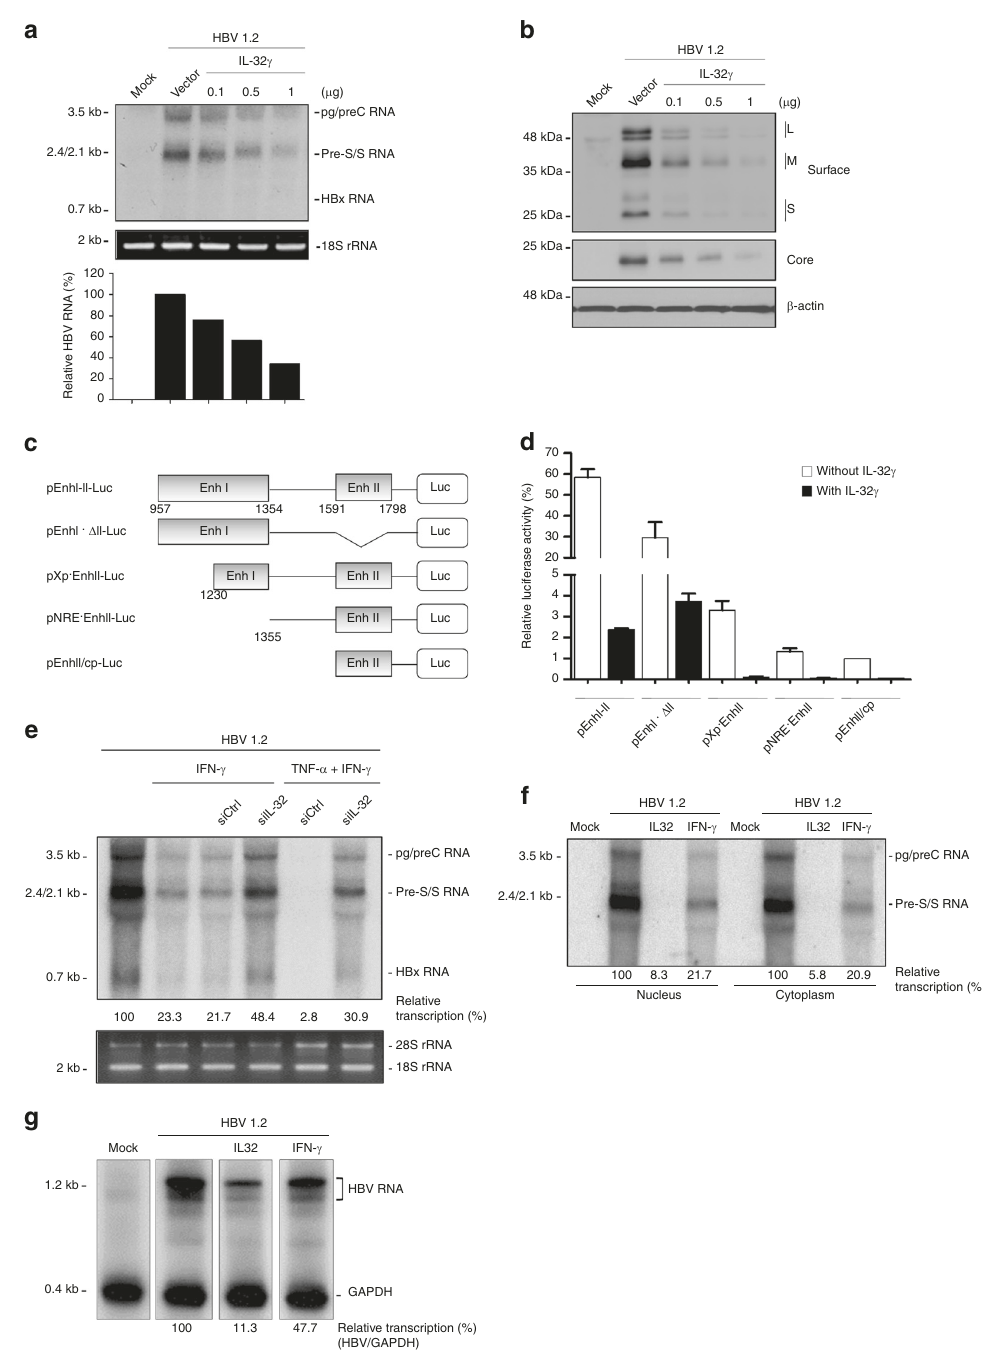
Fig. 3 IL-32 γ suppresses HBV transcription by downregulating viral enhancer/core promoter activities. a , b At 72 h post-co-transfection of Huh7 cells with HBV 1.2 and IL-32 γ vectors, the levels of HBV RNAs and proteins were determined by Northern and western blotting, respectively. The 18S RNA was used as a loading control. c Cartoon of various HBV enhancer reporter mutants used in this study. d Effect of IL-32 γ on each enhancer reporter mutant in Huh7 cells. Relative luciferase activity of each enhancer clone was determined at 48 h post-co-transfection with either empty or IL-32 γ vector. e HBV 1.2 and siRNAs (20 nM) were co-transfected into Huh7 cells. Next day, the cells were treated with cytokines (TNF- α and IFN- γ ) in fresh medium. At 72 h post- transfection, the cells were harvested and the levels of HBV RNAs were determined by Northern blot analysis. f Huh7 cells were co-transfected with HBV 1.2 and empty or IL-32 γ vector. Next day, the cells were treated with IFN- γ . At 72 h post-transfection, the cells were harvested and nuclear and cytoplasmic fractions were isolated. Total RNA was extracted and subjected to Northern blot analysis. g Analysis of HBV transcription rate by nuclear run-on assay using the nuclear fractions shown in f . The level of HBV transcription was normalized to that of GAPDH RNA. Data ( d ) were obtained from three independent experiments (mean ±